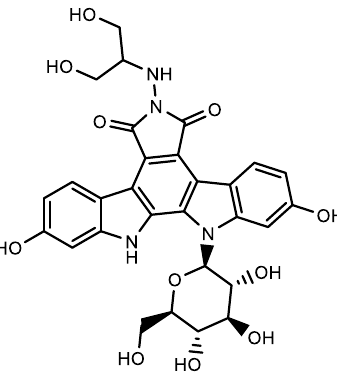
Figure 4. Structure of edotecarin ( 8 ) .